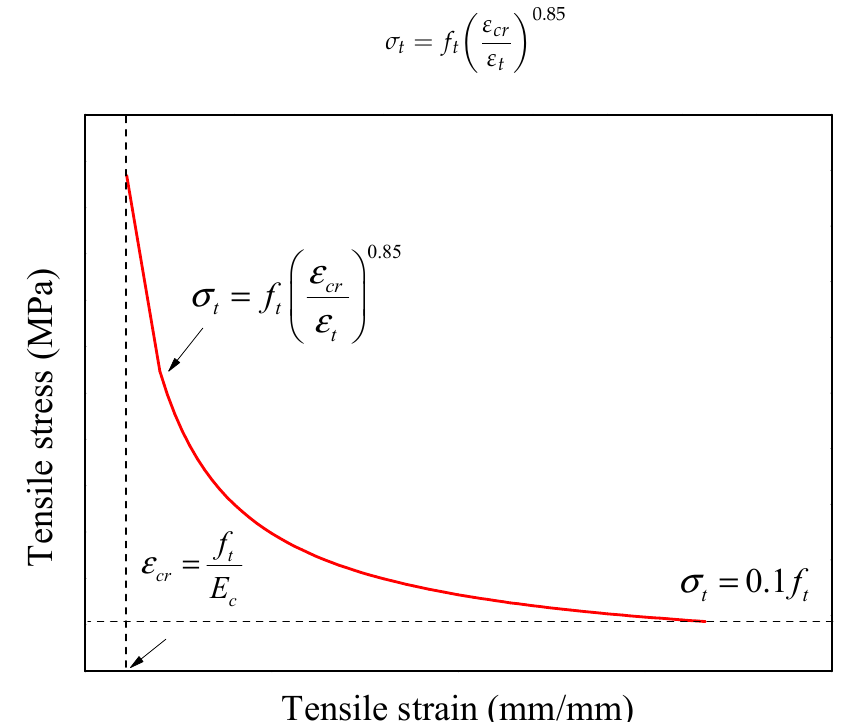
where ε ocel and ε otel are the elastic strains of concrete under compression and tension stresses and calculated respectively as ε ocel = σ c / E c and ε otel = σ t / E c . Figure 5 finally defines the behavior of unconfined concrete under tensile loads (Equation (12)) [84]: